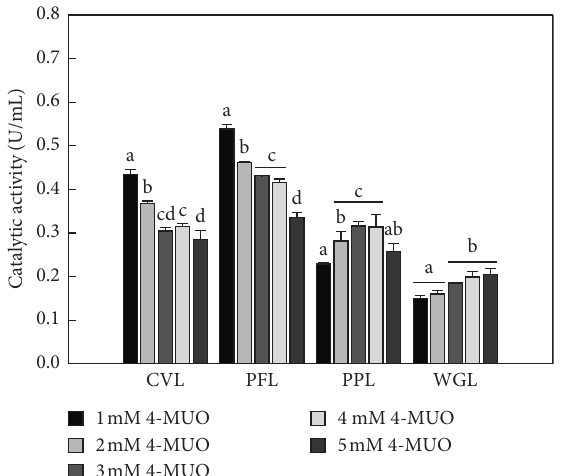
Figure 4: Effects of substrate (4-methylumbelliferyl oleate, 4- MUO) concentration on the catalytic activity of lipases. The substrate concentration was in the range of 1–5mM. Error bars indicate the standard error of the mean. Superscripts (a–d) above the bars denote significant differences in catalytic activity ( p < 0 . 05, Duncan’s multiple range test on ANOVA). CVL, Chromobacterium viscosum lipase (0.1 μ g/mL); PFL, Pseudomonas fluorescens lipase (0.1 μ g/mL); PPL, porcine ( Sus scrofa ) pancreatic lipase (10mg/ mL); WGL, wheat germ ( Triticum aestivum ) lipase (1 mg/mL).